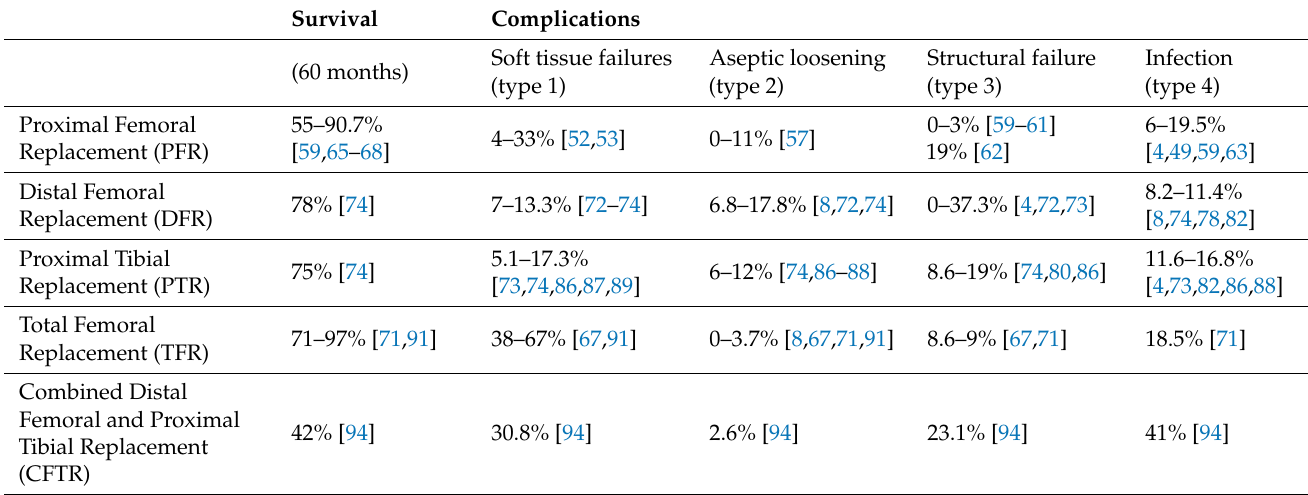
Table 2. Summary of survival and complications “Lower